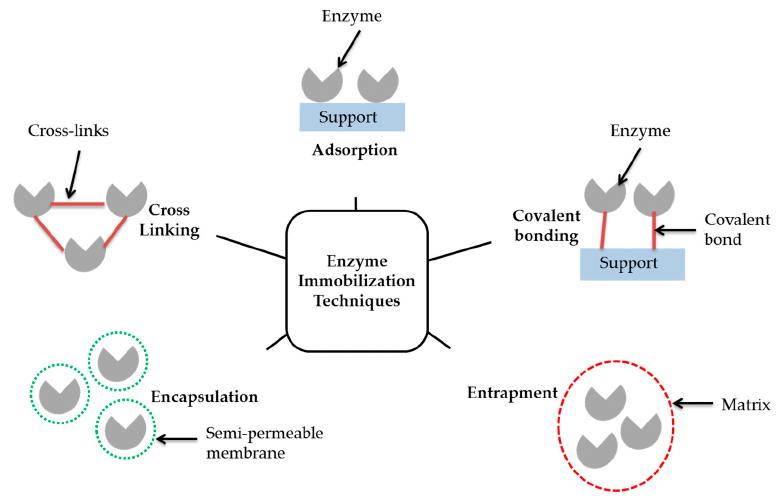
Figure 1. Scheme of various enzyme immobilization techniques.